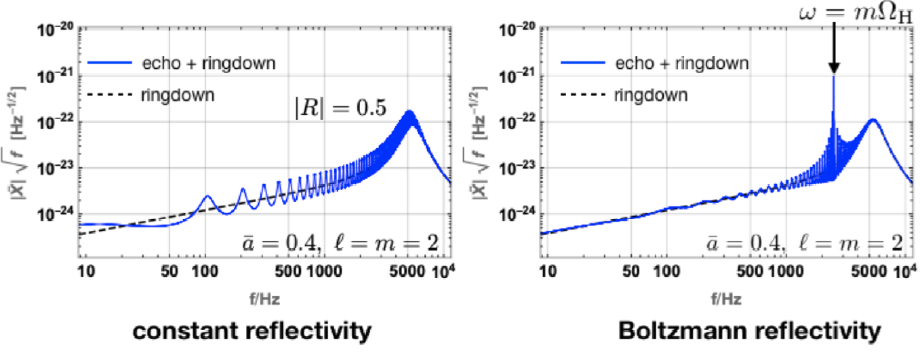
, (cid:101) rd = 0.01, D o = 40 (cid:12) = 0.5 |R|